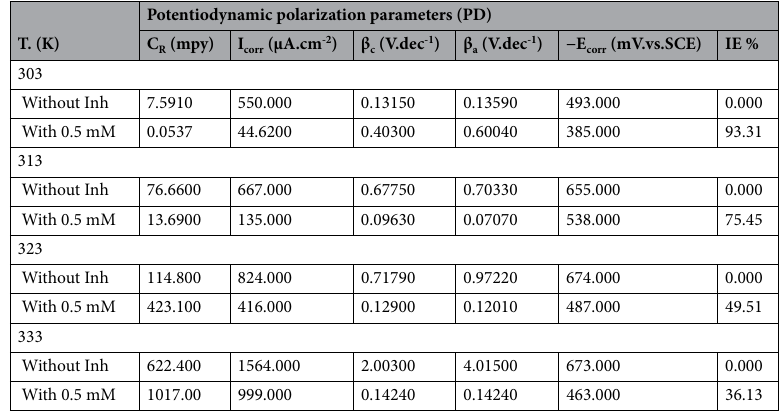
Table 6. Polarisation parameters for MS in 1.0 M HCl with 0.5 mM nonanedihydrazide at variable temperature conditions.